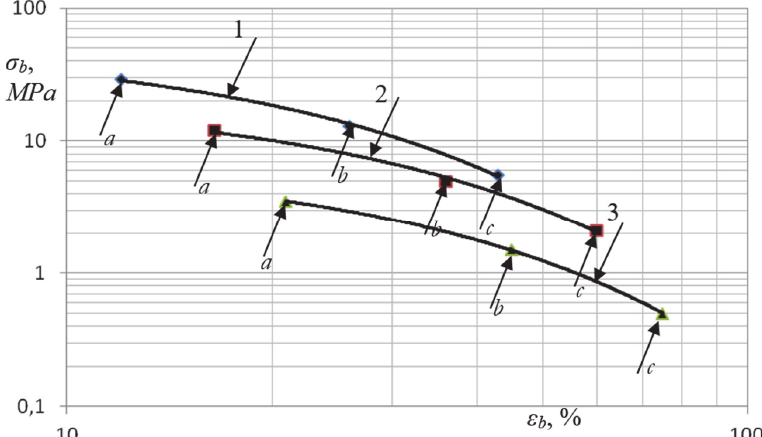
Figure 1: Envelopes of rupture points for polymer composite material according to T. L. Smith for different filler fraction values at 0.05 plasticizer volume fraction in the binder and ν ch = 3 mol/m 3 at different temperatures of numerical experiment. Experiment temperature : 1 – 223 К ; 2. – 273 К ; 3. – 323 К ; a - Two-fraction silica; b - Four-fraction silica; c - Three-fraction